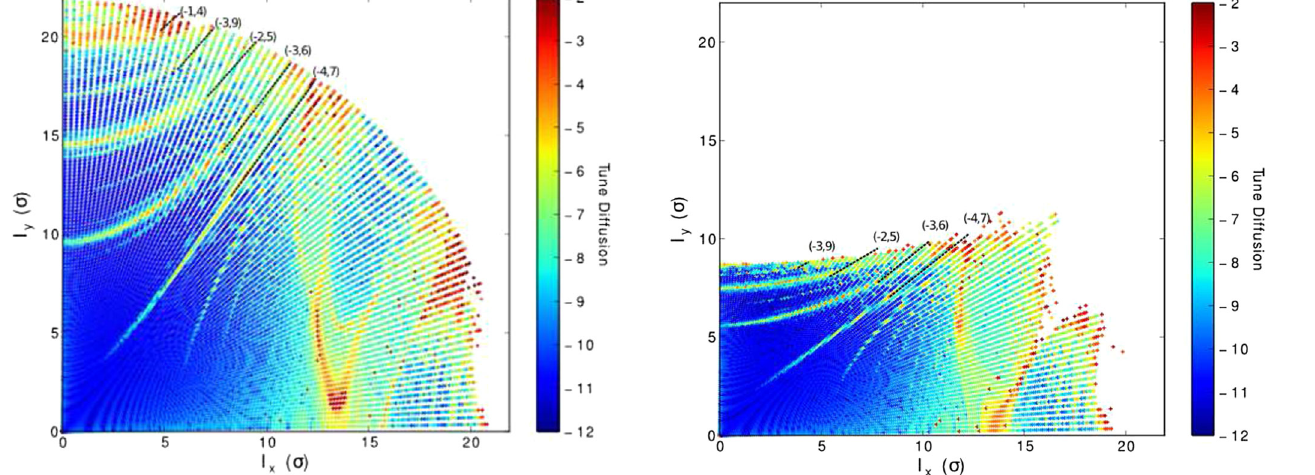
FIG. 21. Diffusion factor D over the initial amplitudes I ¼ 0 – 22 σ and 90 initial angles for the lattice L (cid:1) ¼ 17 m and β (cid:1) ¼ 10